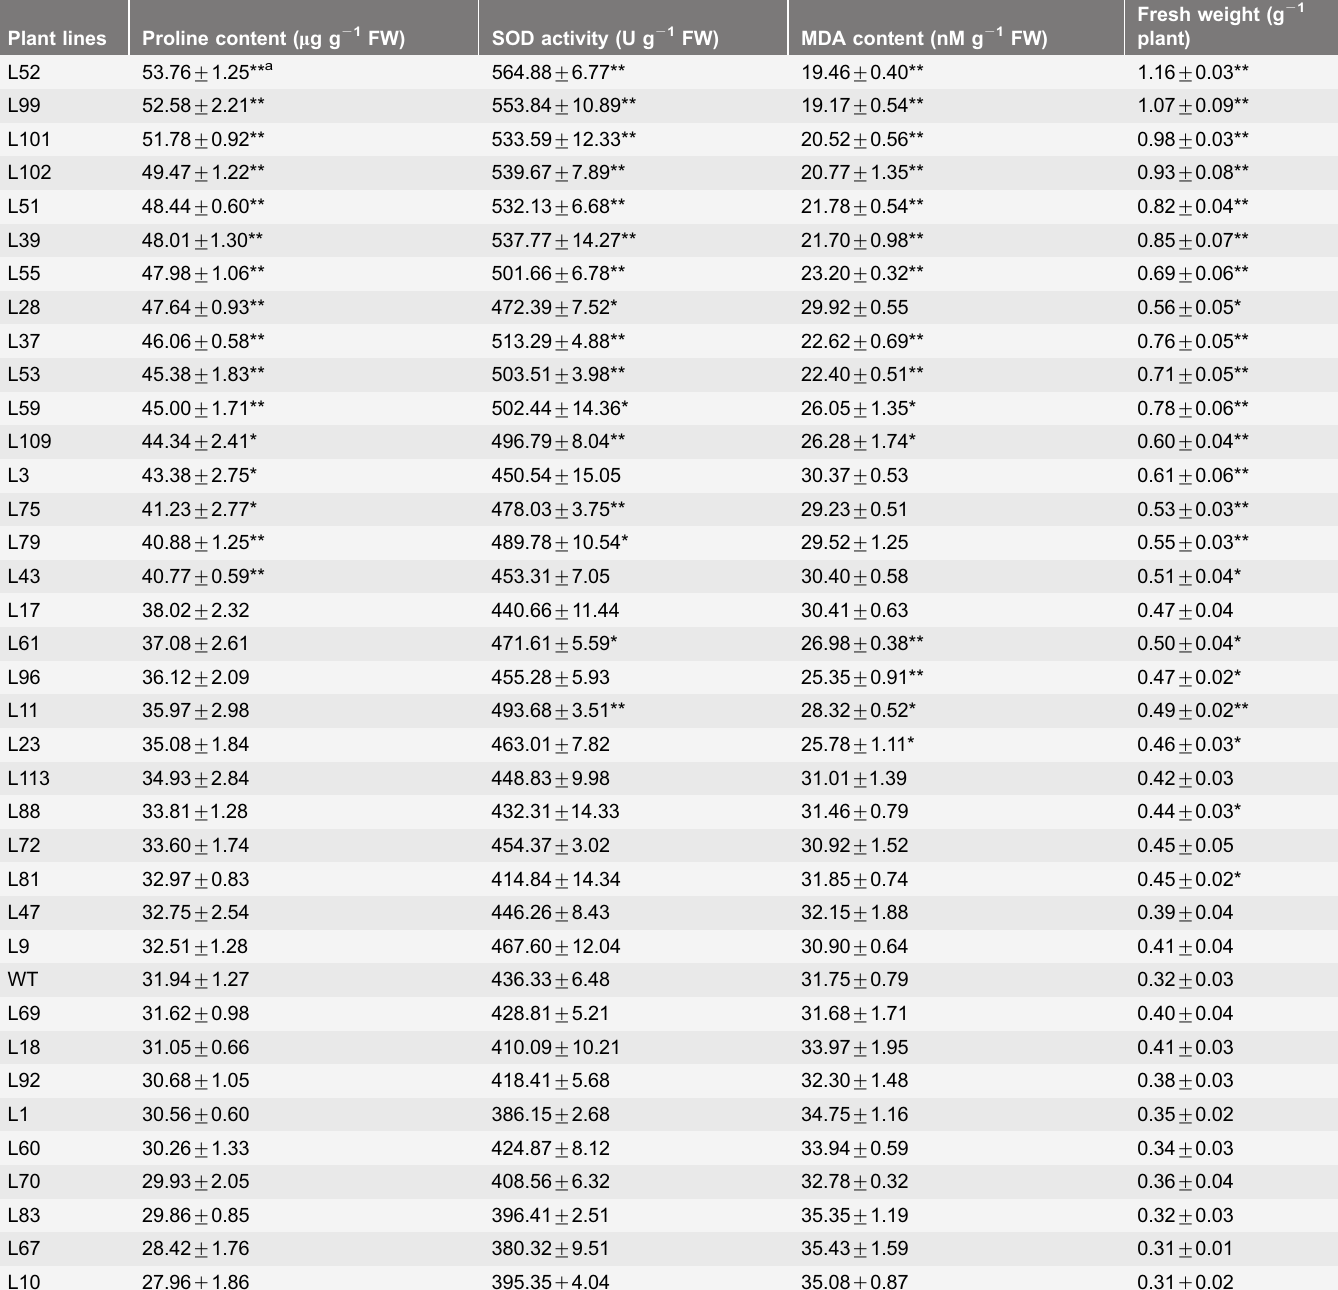
Table 2. Comparison of salt tolerance between the IbMas -overexpressing plants and wild-type plants. Plant